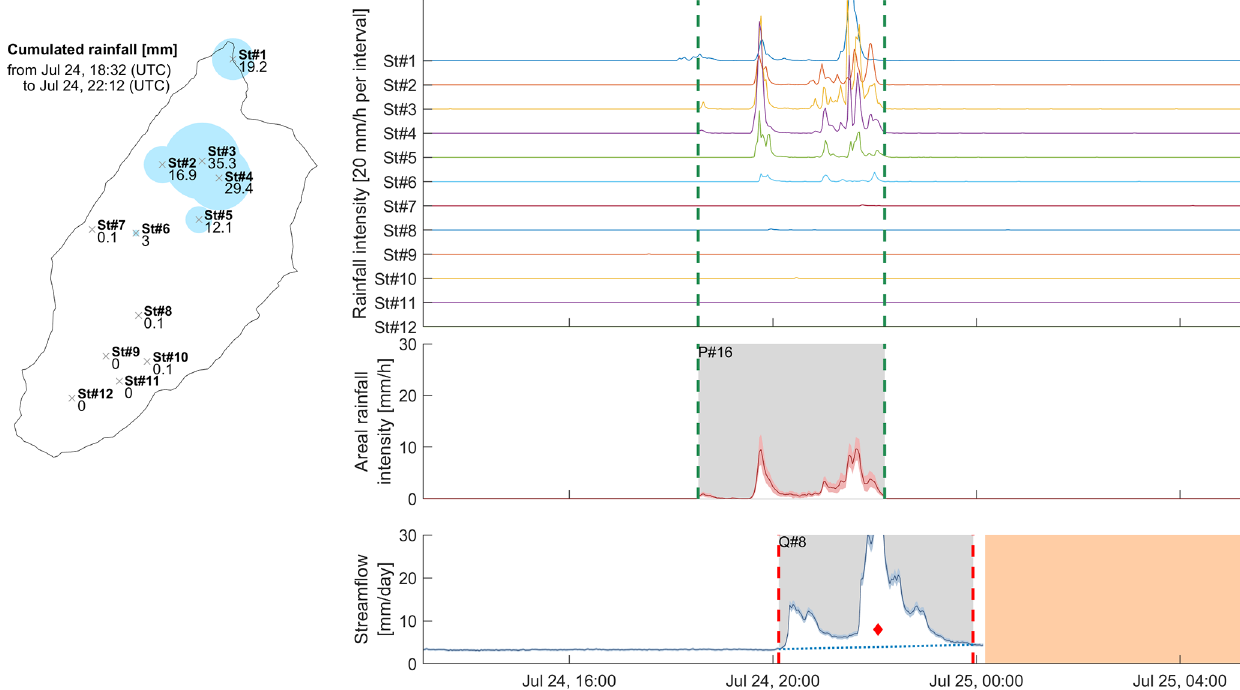
Figure 3. Summary of the recorded rainfall and streamflow for the rainfall event of 24 July 2018 at 18:32 universal coordinated time (UTC; hereinafter, all times are given in